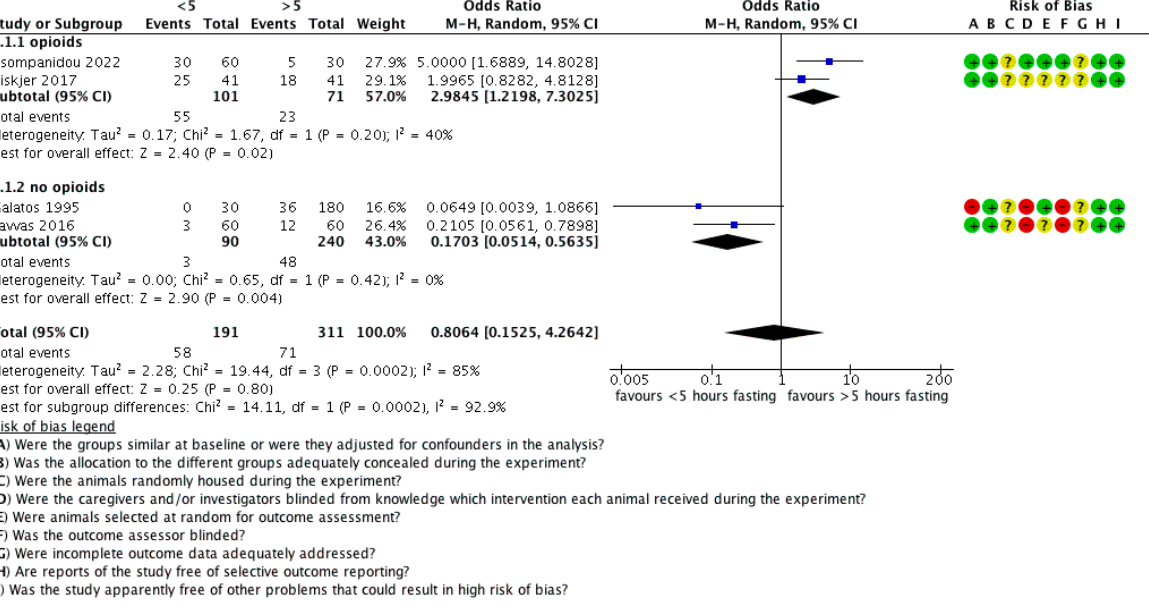
Figure 4. Forest plot of the effect of fasting time on GOR. CI: confidence interval. ?: unclear risk, − : high risk; +: low risk.